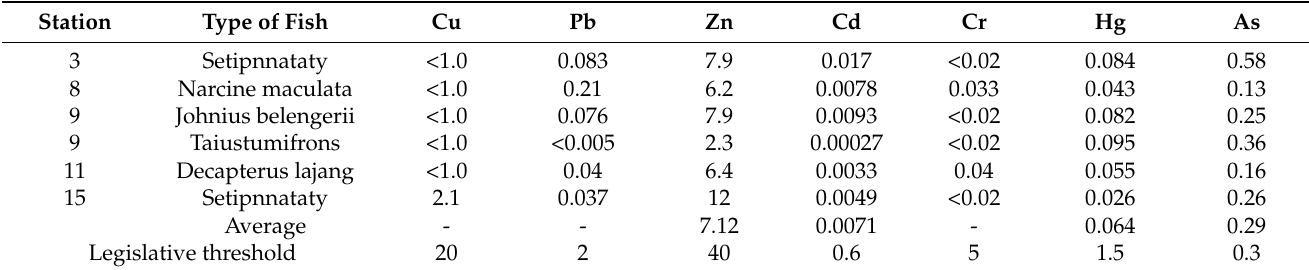
Table 9. Contents of heavy metals in fishes ( n = 6) obtained from Haikou Bay and adjacent waters Unit: mg/kg.